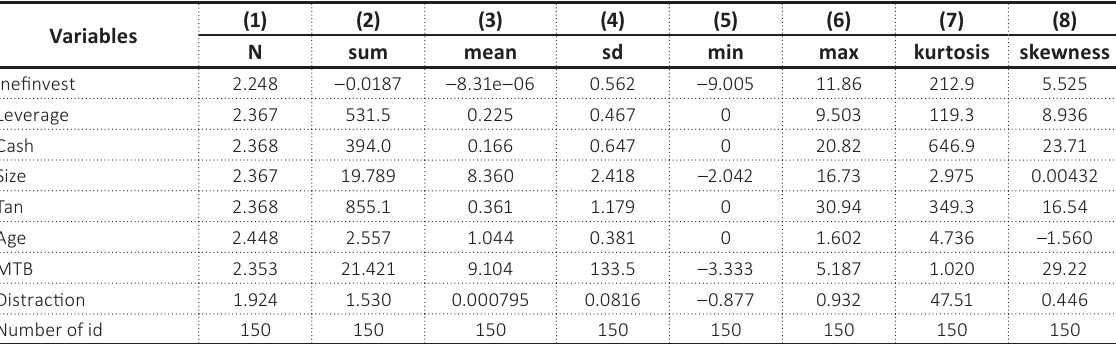
Table 1. Summary